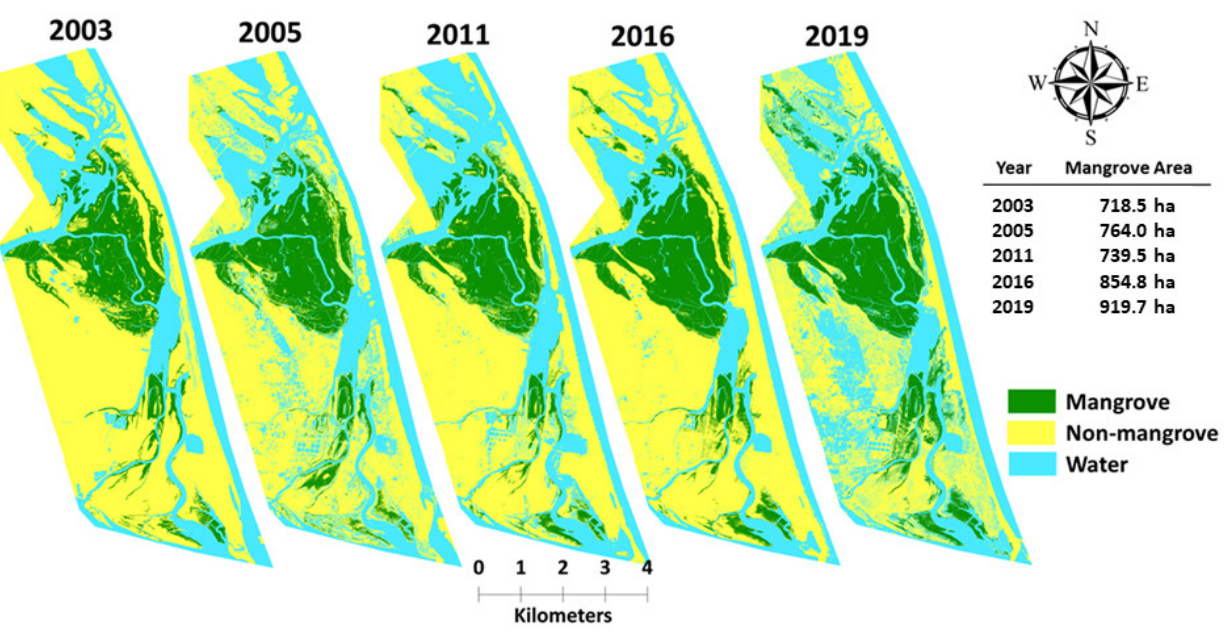
Figure 4. Land-cover maps produced from VHSR images (Quickbird for 2003 and 2005, GeoEye-1 for 2011 and 2016, and Worldview-3 for 2019) after supervised classification and visual adjustment; mangrove cover (in hectares) for individual years are mentioned. Between 2003 and 2019, the overall mangrove cover of Pichavaram expanded by about 2 km 2 , from 718.5 ha to 919.7 ha, (Figure 5a). The area of natural mangroves increased by 62 ha from 600 to 662 ha while the area of mangroves planted in fishbone plots expanded by about 139 ha from 118.5 to 257.7 ha.